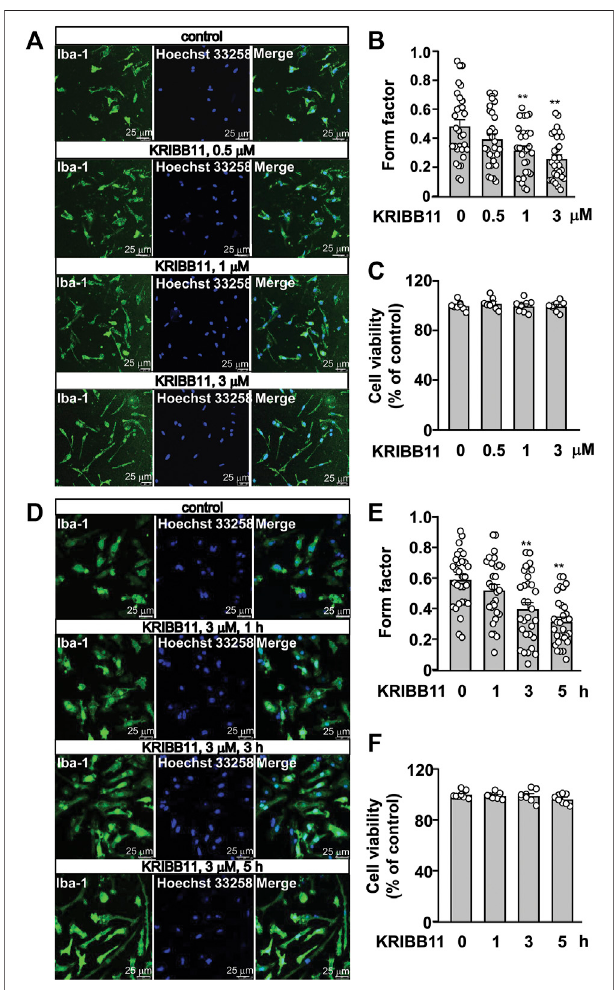
FIGURE 1 | Dose- and time-dependent effects of KRIBB11 on the processes in primary cultured microglia. (A,B) Representative images (A) and quantitative analysis (B) showed that KRIBB11 induced signi fi cant elongations of the processes in primary cultured microglia at the dosages of 1 and 3 μ M (* p < 0.05 or ** p < 0.01 vs. vehicle). (C) Quantitative analysisshowedtheeffectofKRIBB11(0.5,1,3 μ M;5 h)onmicroglialviability ( n = 8). (D,E) Representative images (D) and quantitative analysis (E) showed thepro-elongationeffectofKRIBB11onprimaryculturedmicroglialprocessat time points ranging from 1 to 5 h (** p < 0.01 vs. vehicle). (F) Quantitative analysisshowedtheeffectofKRIBB11atdifferenttimepoints(3 μ M;1,3,and 5 h) on microglial viability ( n = 8). For cell shape investigation, 30 cells per conditionwereselectedinthreeindependentexperiments.Scalebars:25 μ m. Data are shown as mean ±